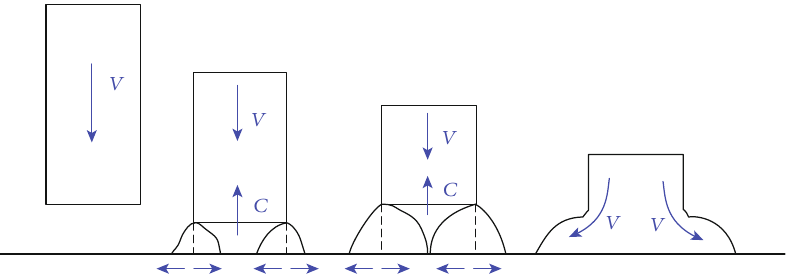
Figure 2: Schematic diagram of the initial stage of water jet impact on the solid surface [54].